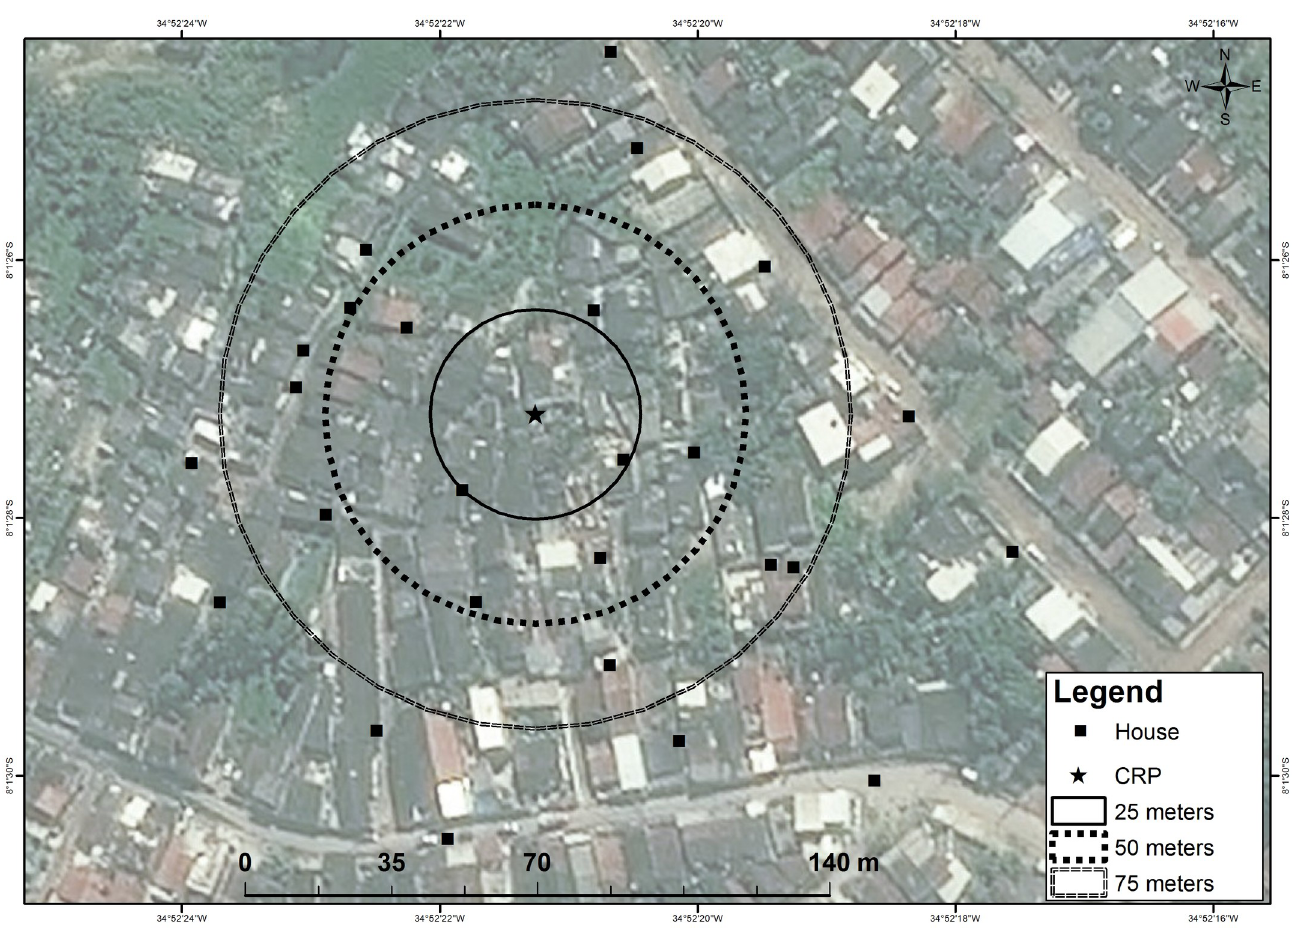
Fig 3. Mosquito mark release recapture (MMRR) collection points via handheld aspirators, Sı´tio Novo, Olinda, RMR, Brazil, July 22–August 21,